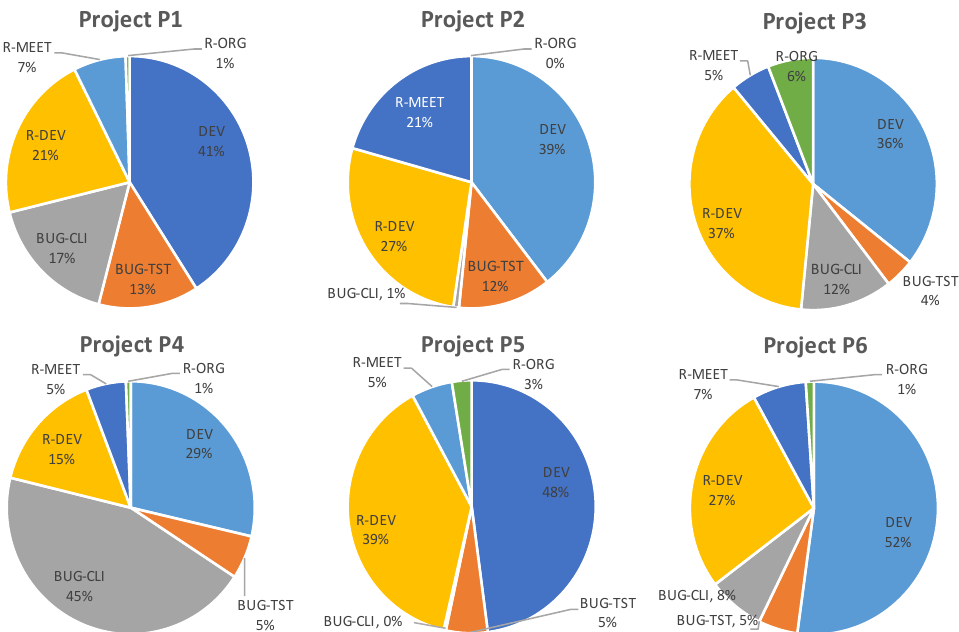
Figure 6. Effort of the six main groups of task types in projects.